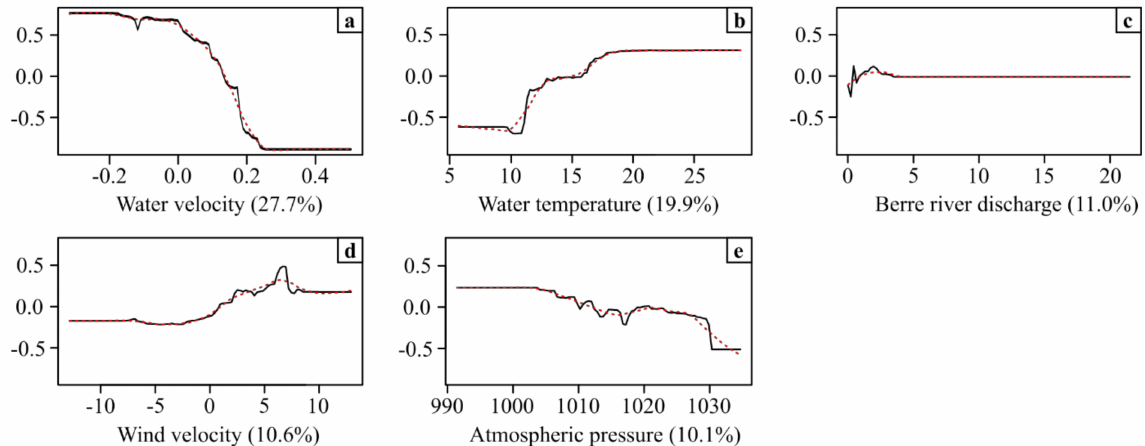
Figure 5. Partial dependence plots of the five most important environmental parameters influencing the number of eels swimming toward the lagoon: ( a ) water velocity (m · s − 1 ), ( b ) water temperature ( ◦ C), ( c ) Berre river discharge (m 3 · s − 1 ), ( d ) wind velocity (m · s − 1 ) and ( e ) atmospheric pressure (hPa). The percentage indicates the relative contribution of each environmental parameter in the BRT. Black lines represent the raw results whereas dashed red lines represent the smoothed